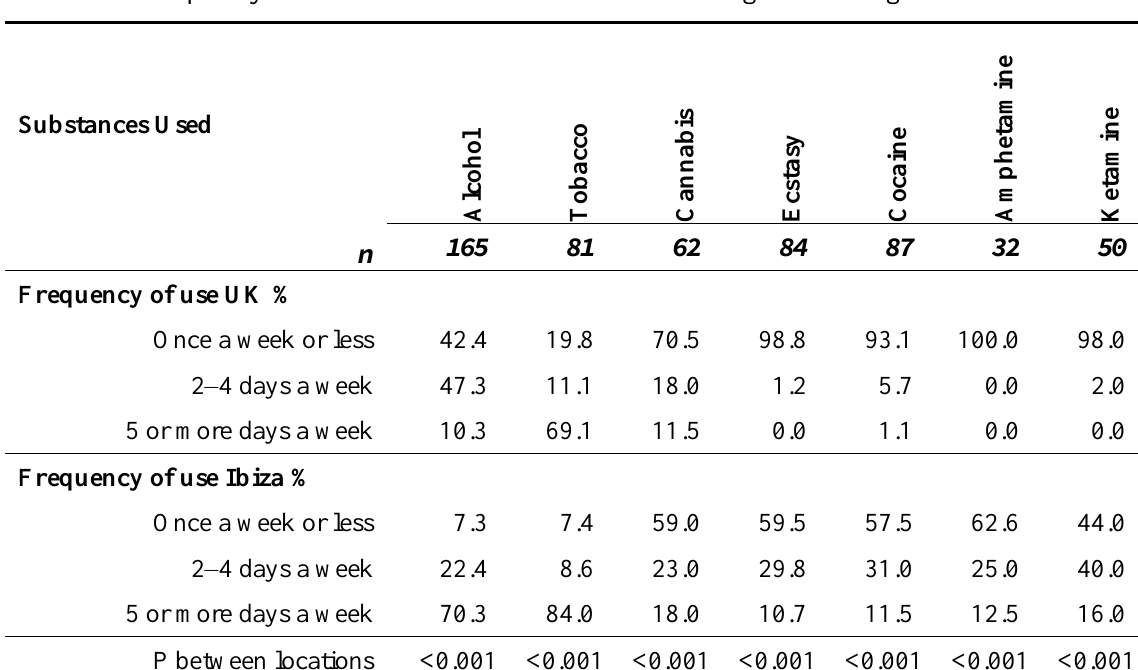
Table 1. Frequency of substance use in UK and Ibiza among those using in both